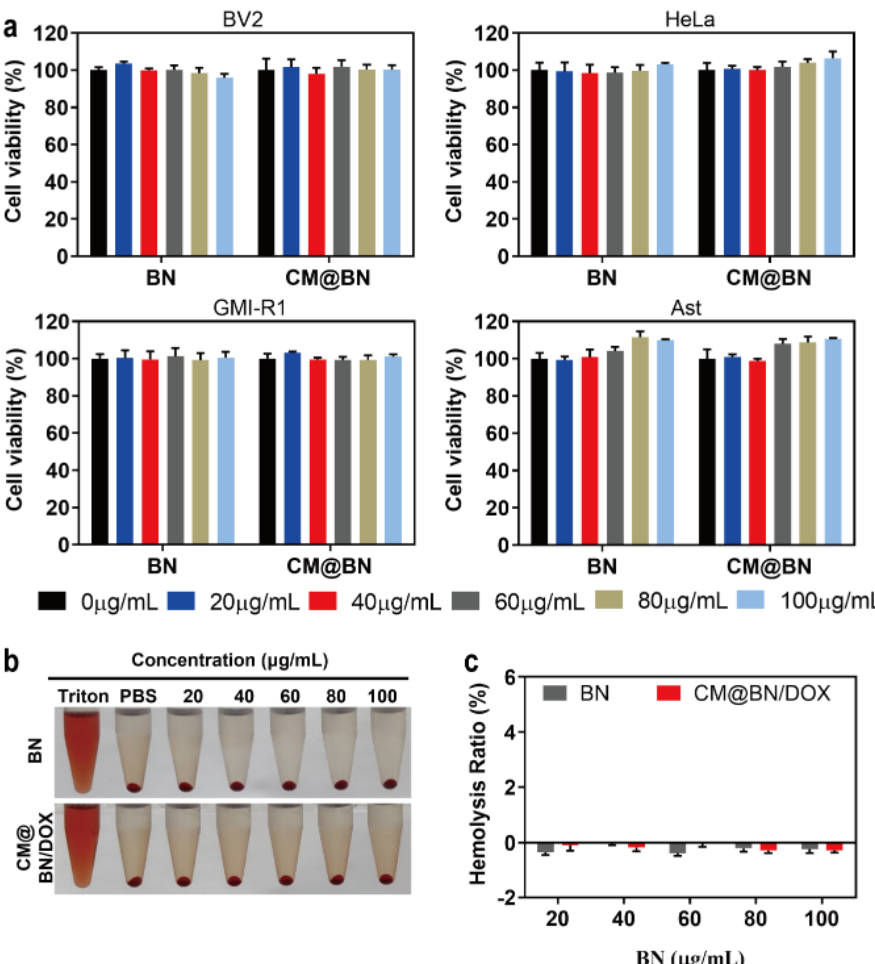
Figure 3. Biocompatibility in vitro. ( a ) The cytotoxicity of BN and CM@BN on various cell lines using concentrations ranging from 0 to 100 µg/mL for a 24-h period. ( b , c ) The hemolysis of red blood cells that were incubated with Triton X-100, PBS, BN, and CM@BN/DOX.